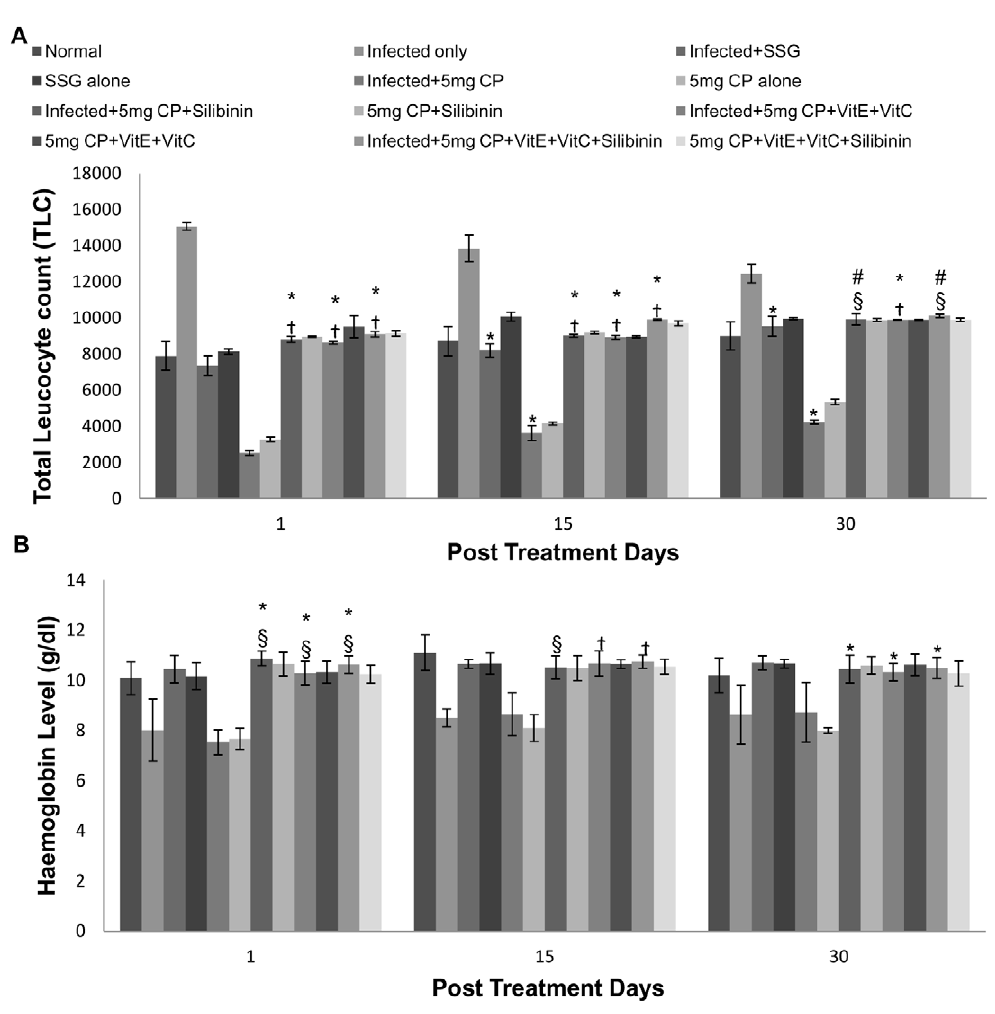
Figure 6. Total leucocyte count and hemoglobin levels in different groups of animals. A- Total Leukocyte Count, B- Hemoglobin levels. The data are presented as mean 6 S.D. of six mice per group. *, # -p value: Infected only vs Infected + SSG/Infected + 5 mg CP/Infected + 5 mg CP + Silibinin/Infected + 5 mg CP + VitE + VitC/Infected + 5 mg CP + VitE + VitC + Silibinin. { , 1 -p value: Infected + 5 mg CP vs. Infected + 5 mg CP + Silibinin/ Infected + 5 mg CP + VitE + VitC/Infected + 5 mg CP + VitE + VitC + Silibinin. *, { -p , 0.001; # , 1 -p ,